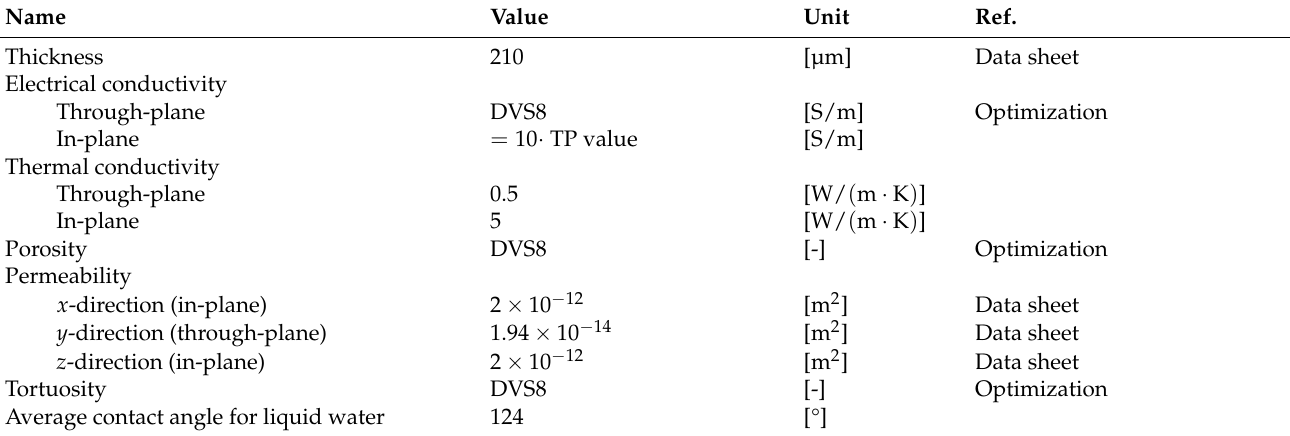
Table A3. Parameters for gas diffusion layers. Conductivity values are effective values.